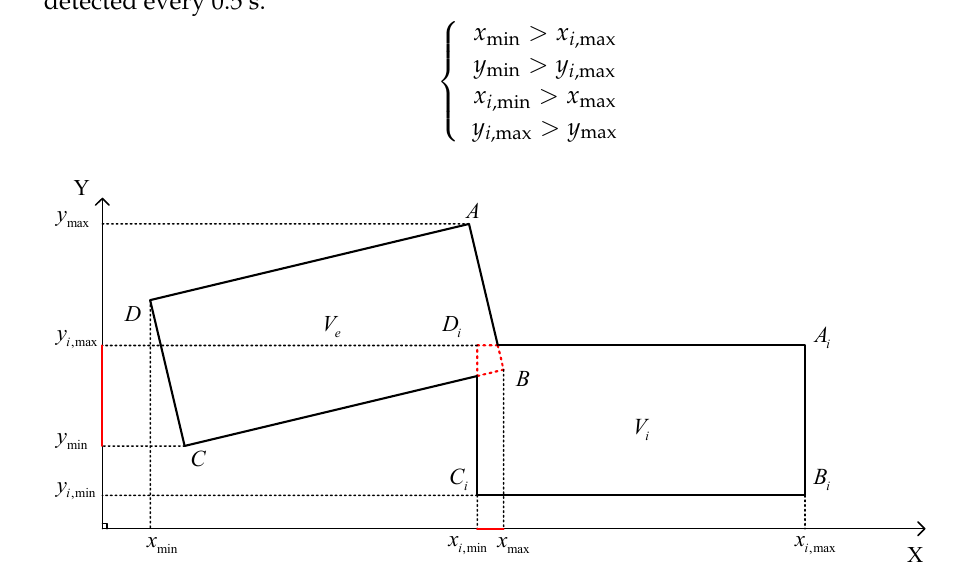
Figure 4. Schematic diagram of collision during lane changing.